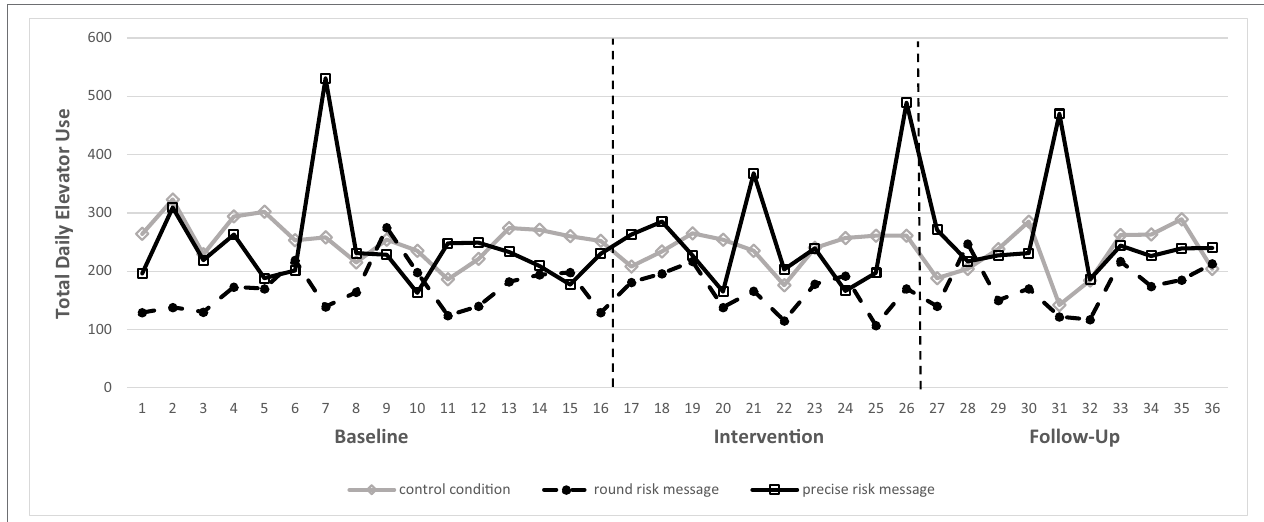
FIGURE 1 | Illustration of elevator use over baseline period, intervention period, and follow-up